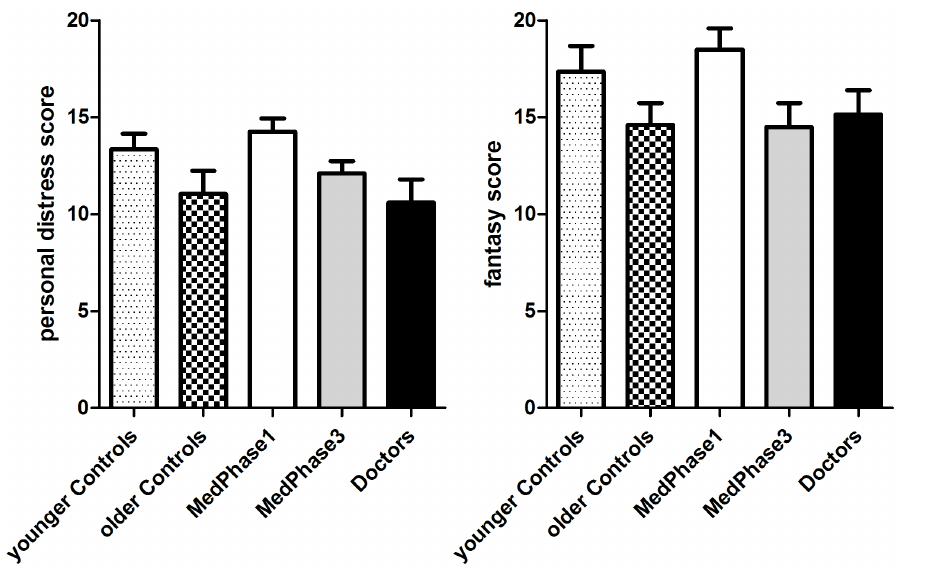
Figure 2. Mean scores for the personaldistress (A) and fantasy (B) subscales of the Interpersonal Reactivity Index (IRI), for the five participant groups. Error bars represent the standard error of the mean. doi:10.1371/journal.pone.0065159.g002 PLOS ONE |